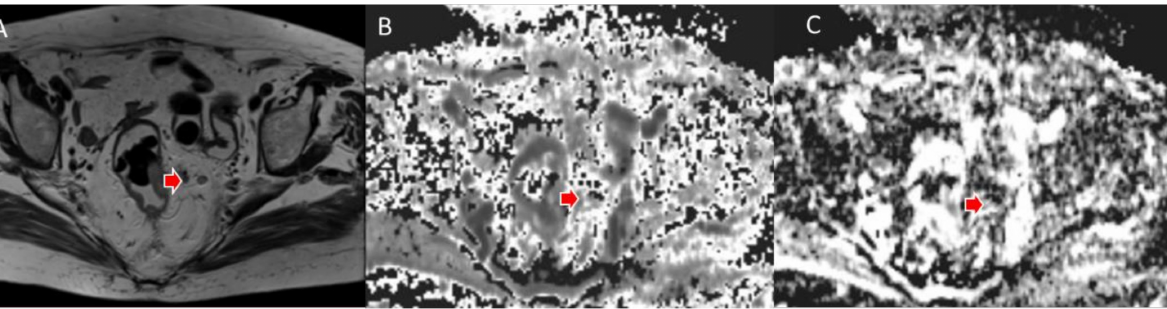
Figure 5. Man 72 y.o. with rectal cancer (same patient as in Figure 3). Nodal assessment (arrow) in T2W sequence ( A ), in MK map ( B ) and MD map ( C